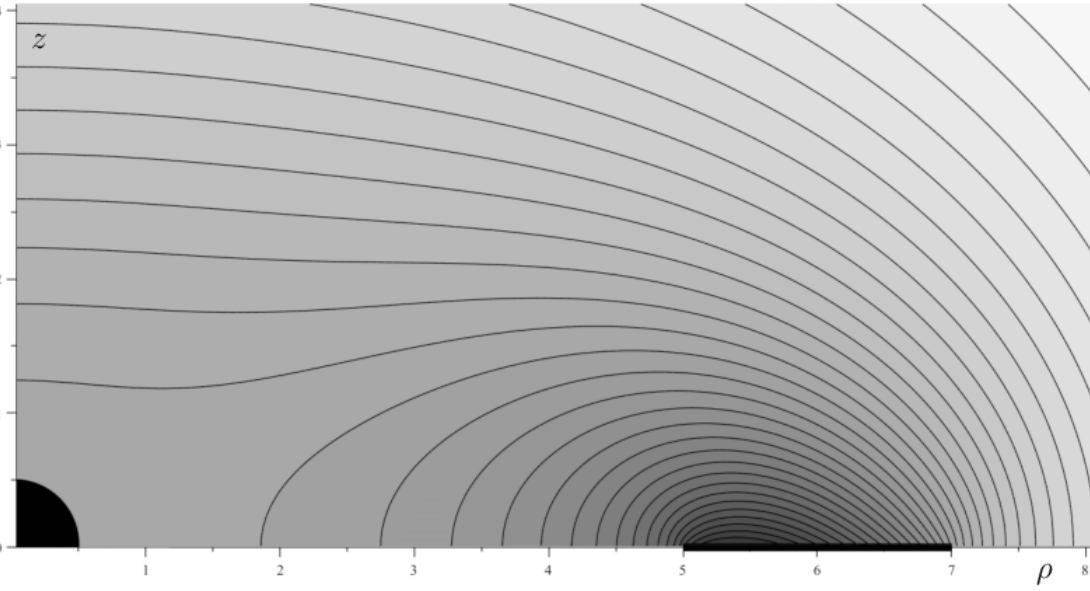
Figure 1. Meridional-plane contours of the dragging angular velocity ω , as entirely given by the first-order perturbation. The disc lies between ρ = 5 M and ρ = 7 M (it is indicated by thick black line). The angular velocity is everywhere positive, with light/dark shading indicating smaller/larger values (the value reaches about 0.0268/ M at the disc and falls off to some 0.0047/ M at top right of the plot); the black quarter-disc at ρ 2 + z 2 ≤ M 2 / 4 is the black hole. Both axes are given in the units of M . Since ω is proportional to W , its isolines have the same shape for any W . Reprinted from [5] by courtesy of the MNRAS